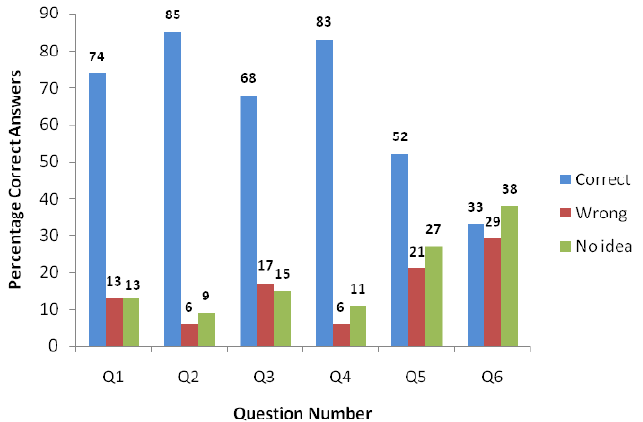
Figure 1: Showing the percentages of the correct, wrong and ‘no idea’ responses to questions 1-6. Those who did not provide answers were considered as having no idea. For most of ques- tions, correct answers were more frequent than incorrect or ‘no idea’ responses.